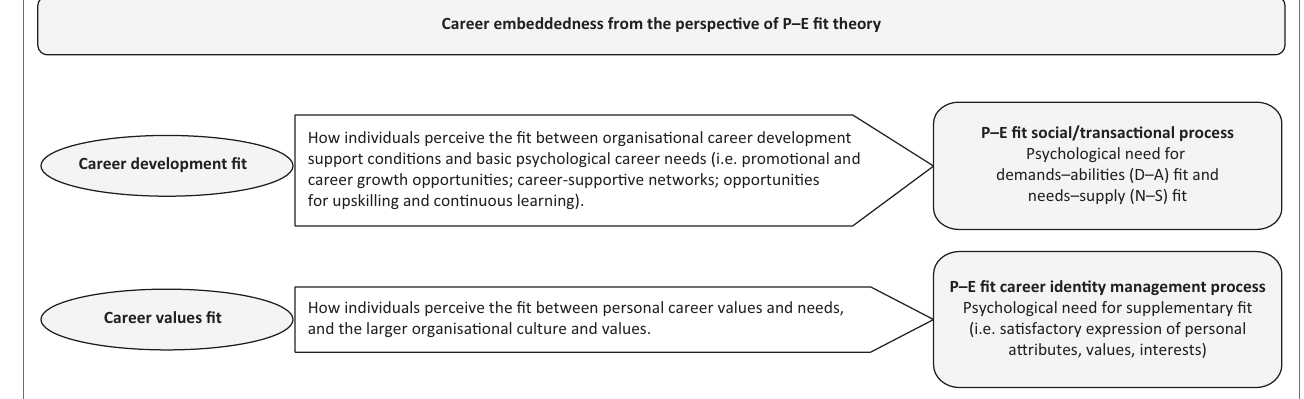
FIGURE 1: Facets of career